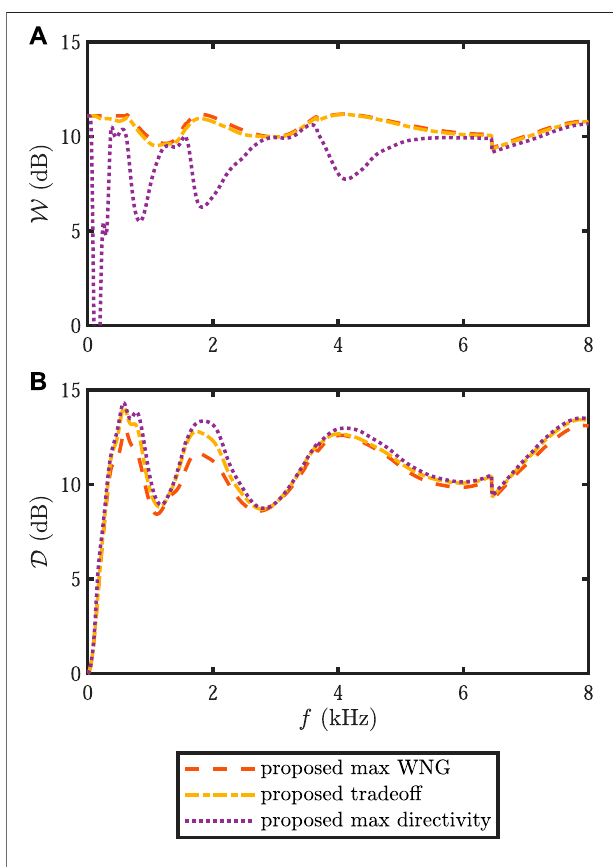
FIGURE 13 | (A) WNG, and (B) narrowband directivity factor as a function of frequency for the star array beamformers: max WNG (dashed line), tradeoff (dash-dot line), and max directivity (dotted line). The obtained W [ 890 Hz , 8 kHz ] are respectively 10.4, 10.3, and 9.2 dB. The obtained D I [ 890 Hz , 8 kHz ] are respectively 10.5, 10.8, and 11.0